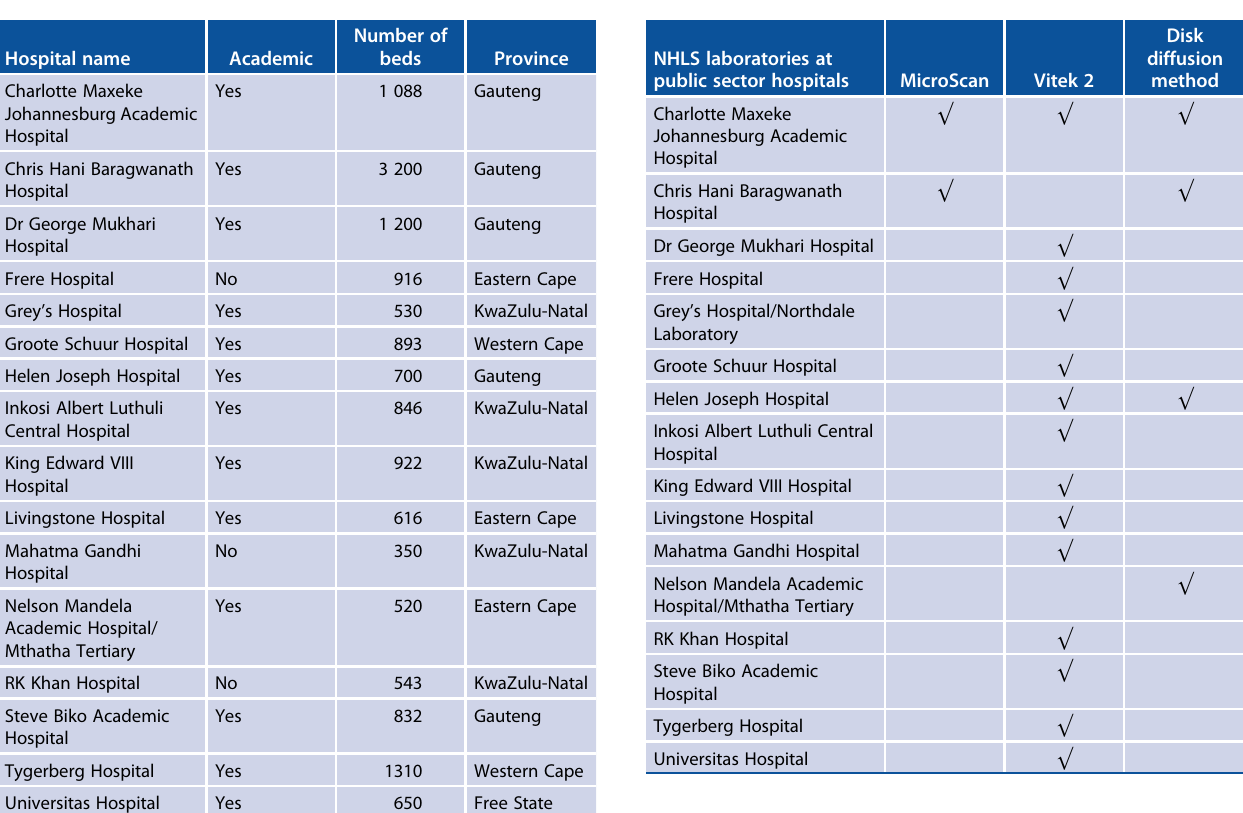
Table 2: Antimicrobial susceptibility testing methods performed at the 16 sentinel hospitals